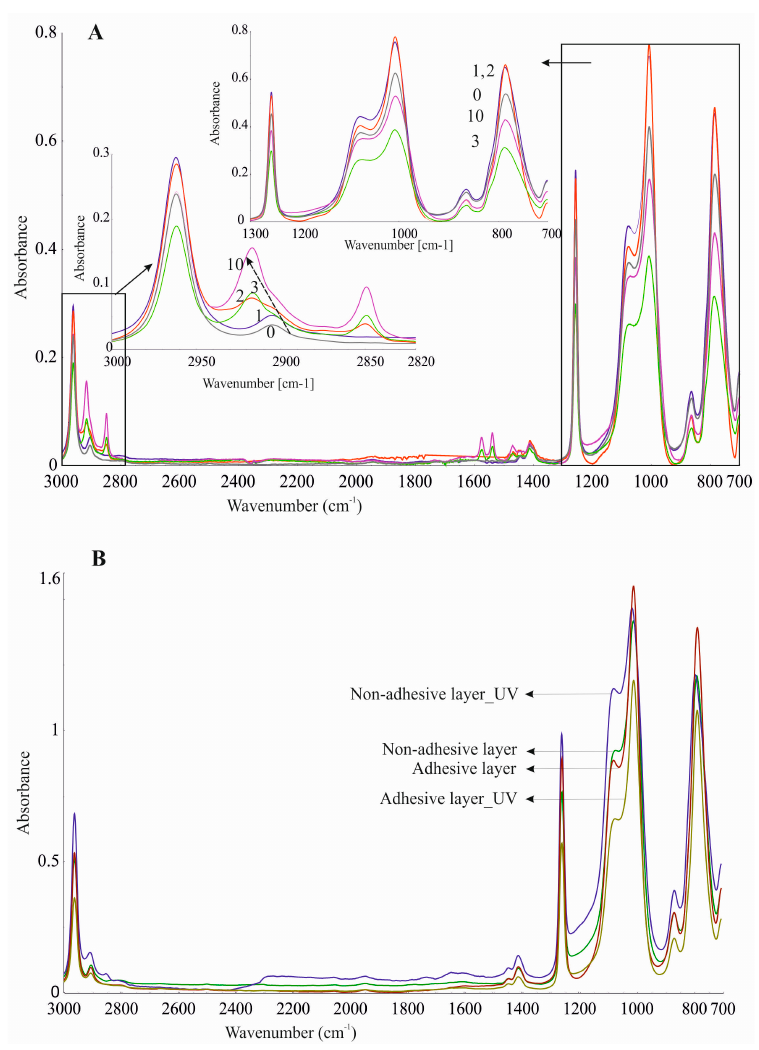
Figure 10. ATR – FTIR spectra recorded during stability testing of DLASil ( A ) adhesive layer during washing 0 – 10 times; ( B ) silicone elastomers after UV irradiation.